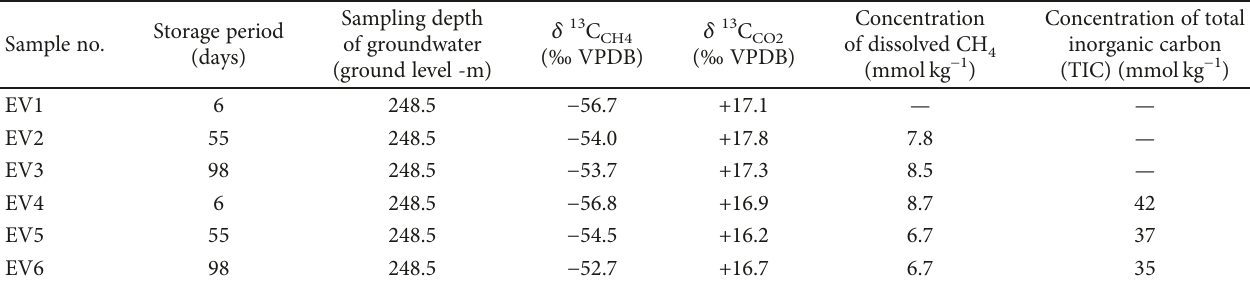
, δ 13 C , methane, and TIC contents in EV CH4 CO2